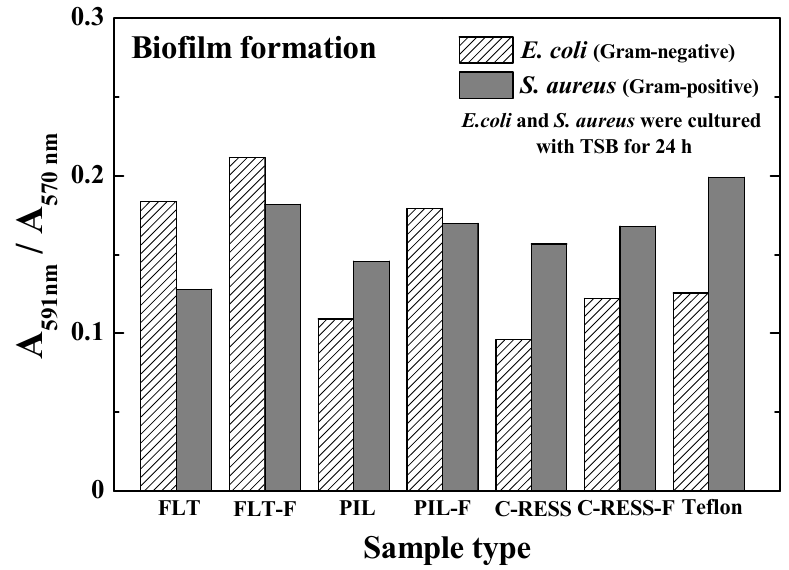
Figure 13. Comparison of the relative biofilm mass accumulation of E. coli (Gram − negative) and S. aureus (Gram − positive) from the static biofilm formation per surface area ( ≈ 3.238 cm 2 ). Note that the E. coli and S. aureus were cultured with TSB medium for 24 h.